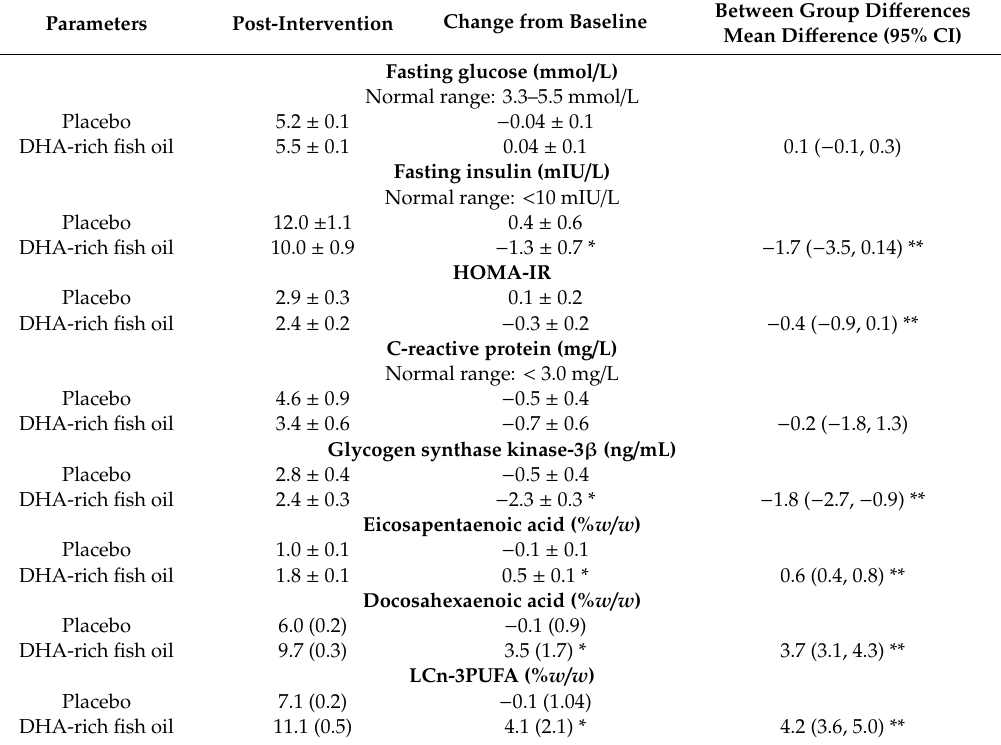
Figure 1. Change in erythrocyte membrane red blood cell (RBC) docosahexaenoic acid (DHA), and total long-chain omega-3 polyunsaturated fatty acids (LCn-3PUFA). Significance set at p < 0.05. Lowercase letters a and b represent significant difference between the placebo and the DHA-rich fish oil groups for LCn-3PUFA and DHA, respectively. Table 2. Changes to the study parameters within and between the placebo and the DHA-rich fish oil groups during the intervention period.